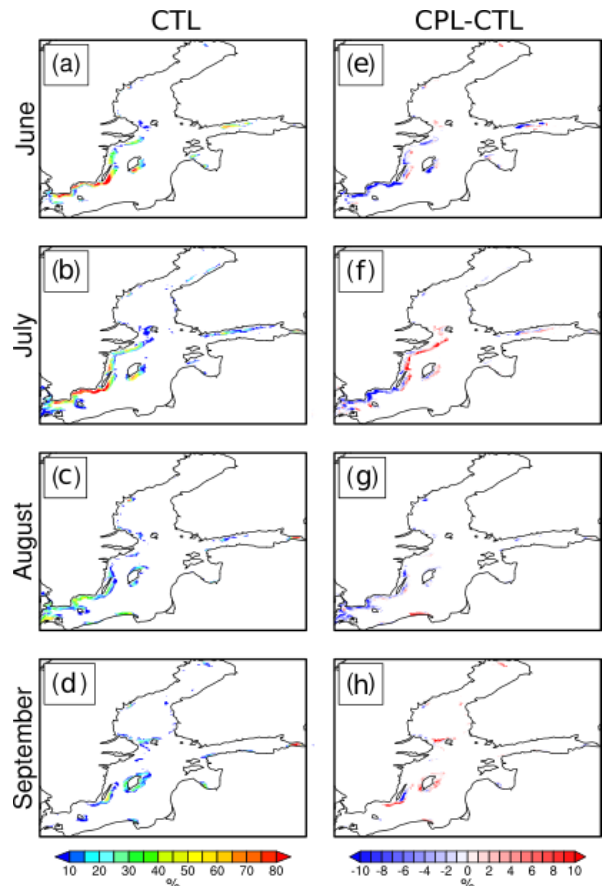
Figure 7. Panels (a) – (d) show the upwelling frequency during the period from June to September 2015, and panels (e) – (h) show the difference between the simulation considering wave influence and the control experiment. (This figure is adapted from Wu et al.,